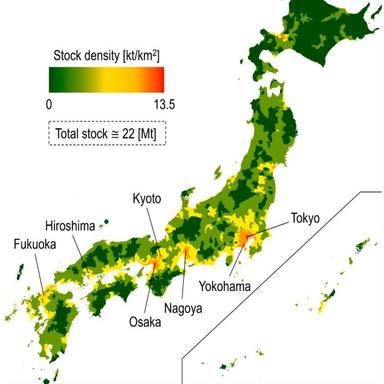
Spatial distribution of in-use total copper stock in Japan in 2011. Municipalities are colored based on geometric interval classification.